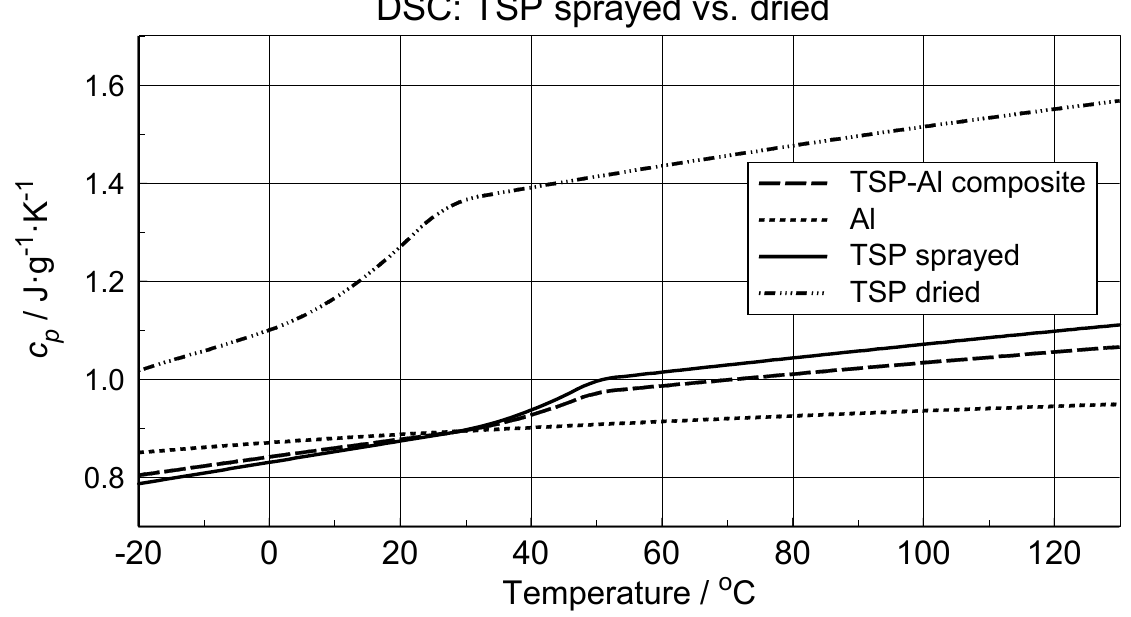
Figure 7. Processed results of microcalorimetric investigation of the TSP specific heat (TSP layer from aerosol spraying) with presentation of intermediate steps of the differential scanning calorimetry (DSC) measurement data approximation and the approximated data of the TSP structure obtained by the drying method.